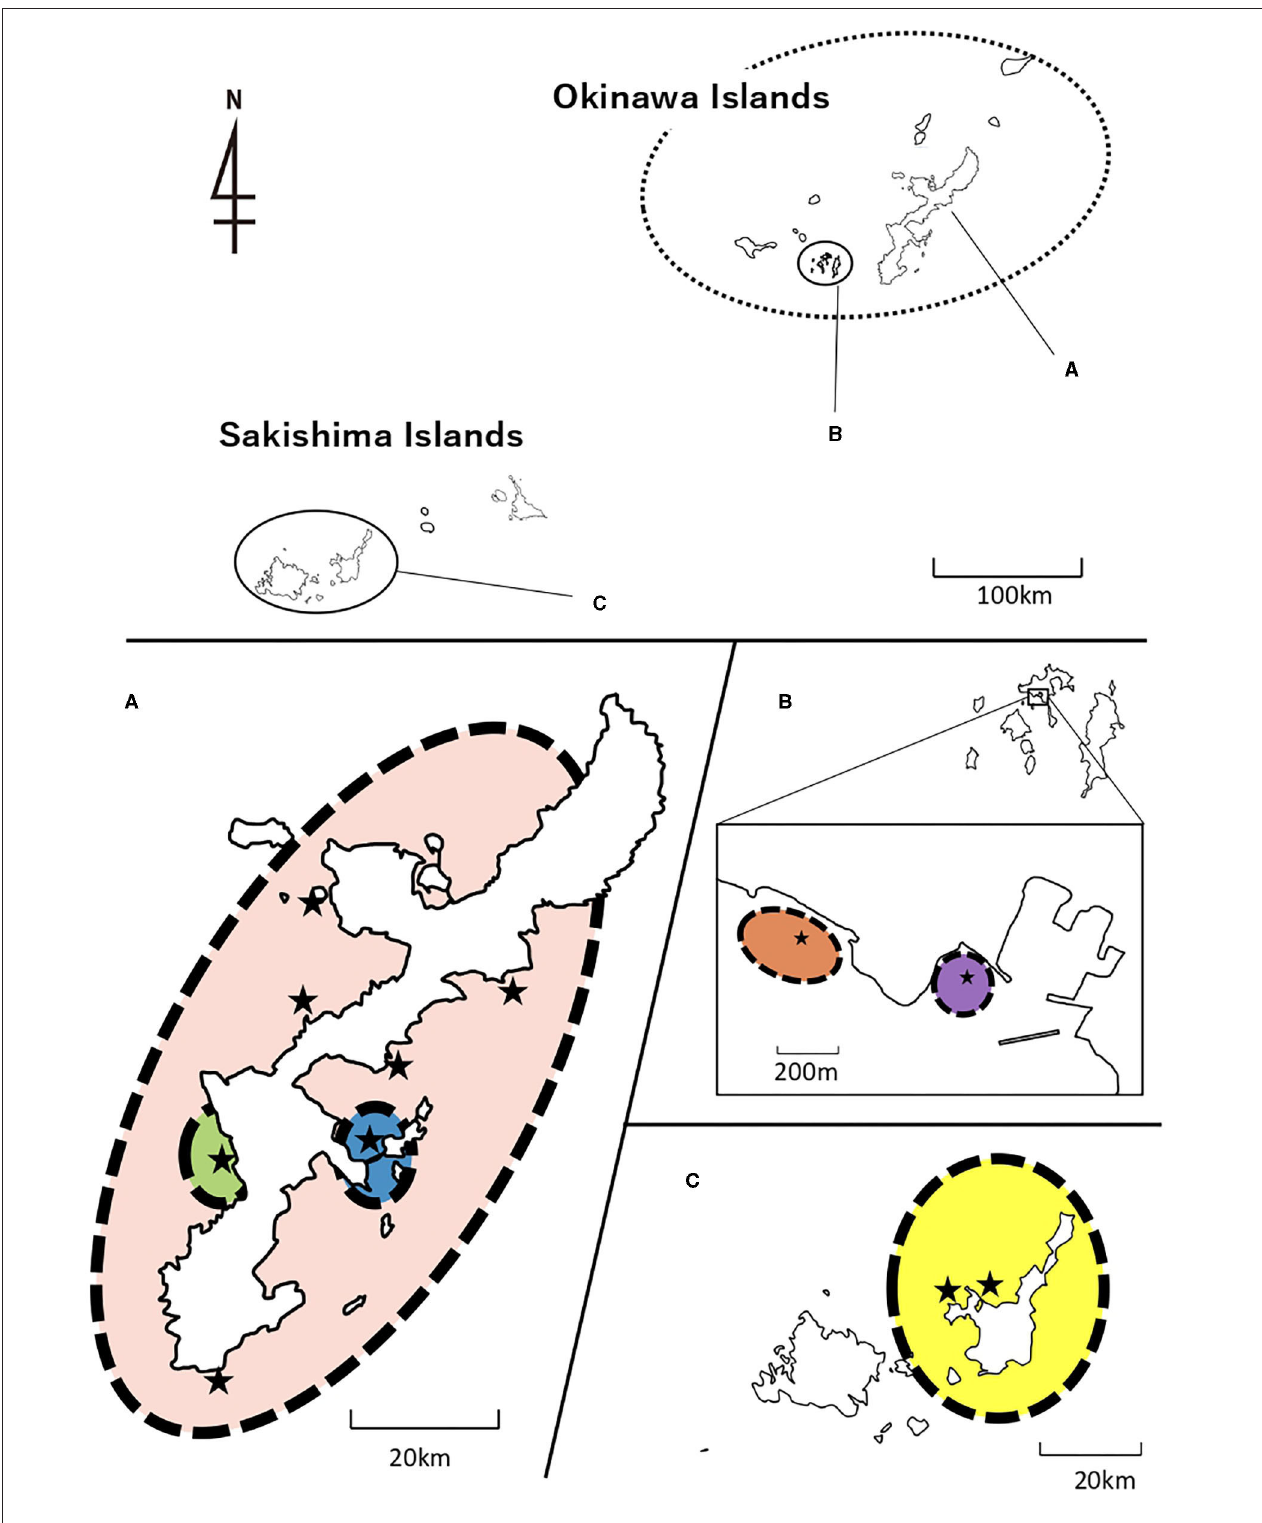
FIGURE 6 | Population structure of H. atra supported with statistically significant values of AMOVA. (A) Okinawajima Island, (B) Kerama Islands including Zamami Island, and (C) Sakishima Islands including Ishigaki Island. Stars represent sampling locations. Colors show different population groups; Blue, Uruma; Green, Chatan; Pink, Rest of Okinawajima Island; Purple, Zamami Port; Orange, Zamami Ama; Yellow, Ishigaki Island. See Table 3 for statistical data.